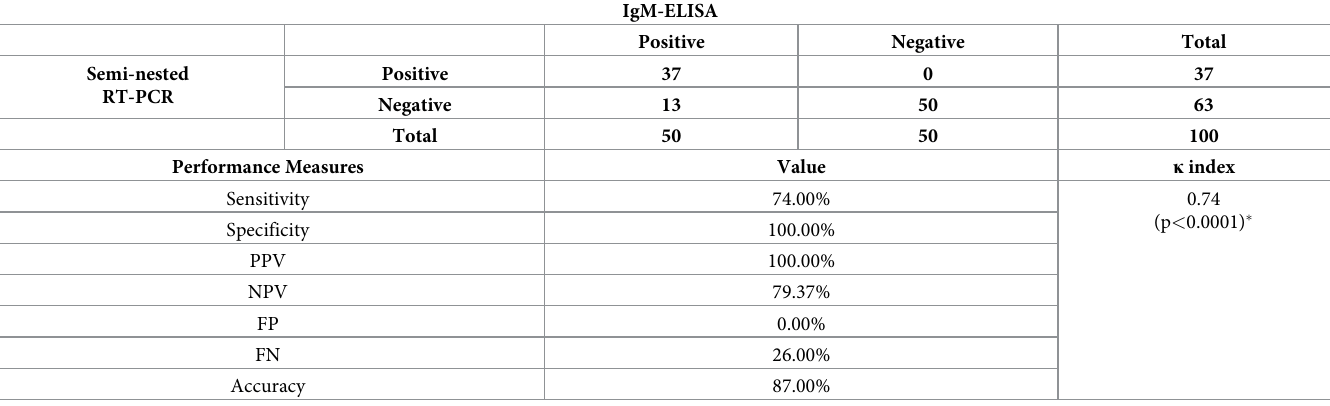
Table 5. Contingency table showing the results obtained by Semi-nested RT-PCR compared with those obtained by IgM-ELISA as reference